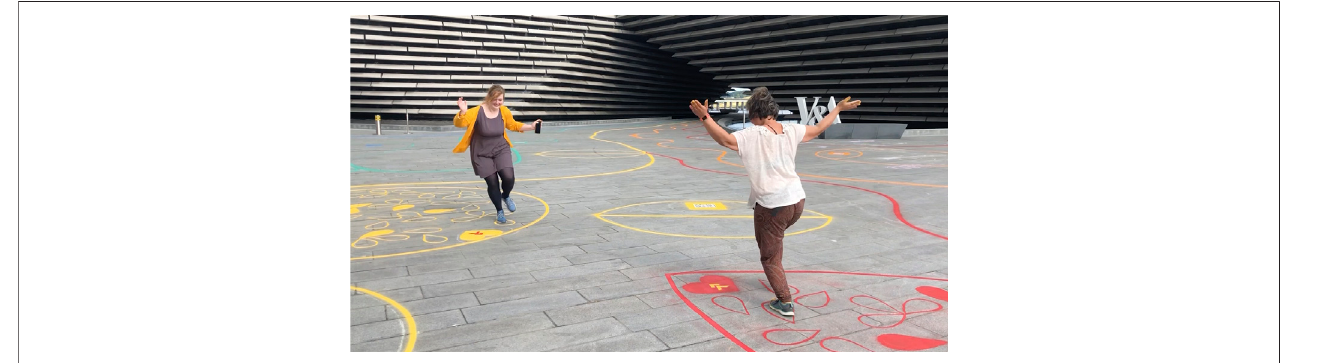
FIGURE 1 | Oneplaything @ V&A Dundee: Slow